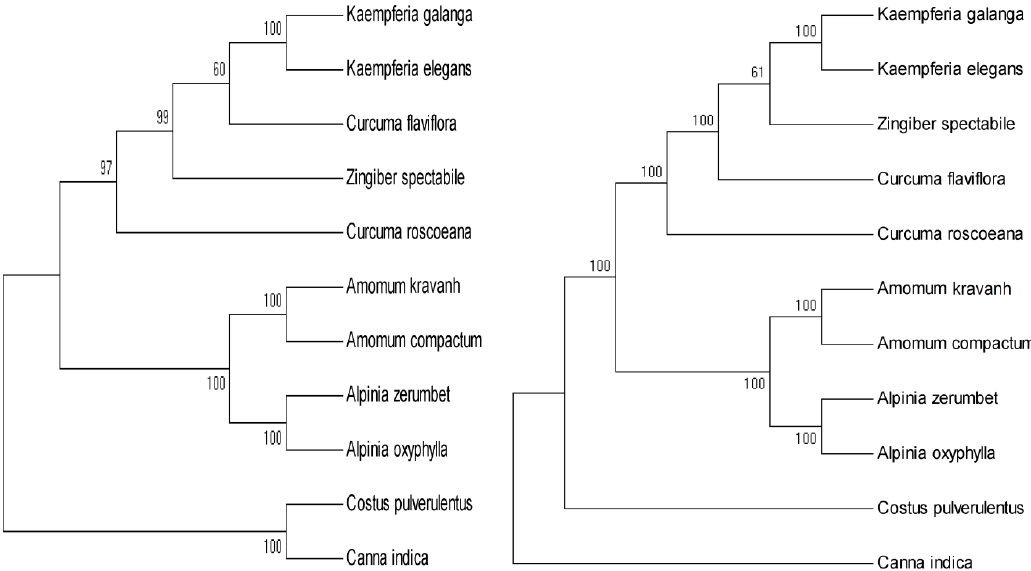
Figure 8. Phylogenetic trees constructed with SNPs from 11 species using maximum likelihood (ML, left) and maximum parsimony (MP, right) methods. Numbers at nodes on the tree indicate bootstrap values (>50%).